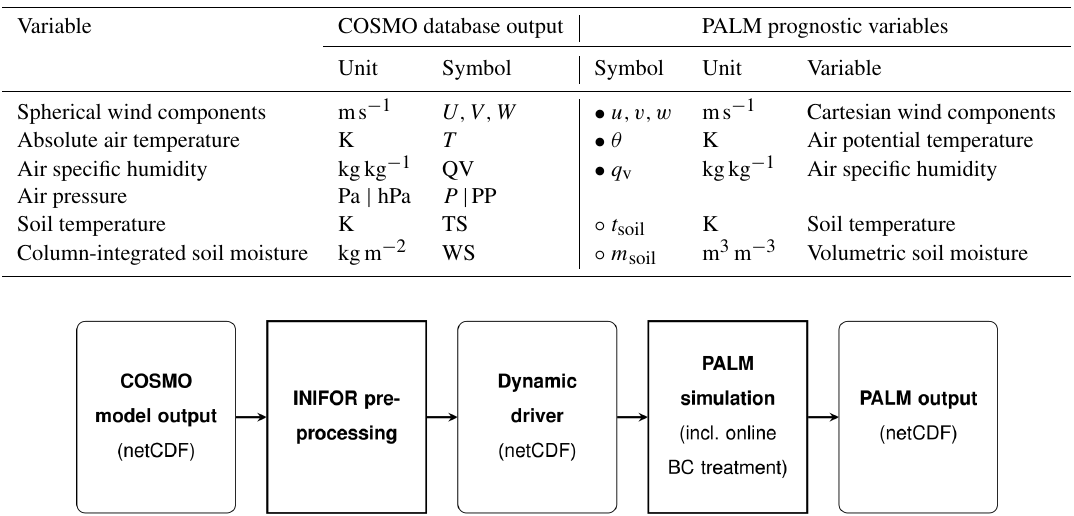
Table 1. INIFOR’s input and output variables. INIFOR supplies initial and boundary conditions for the variables marked with • and initial conditions for variables marked with ◦ .